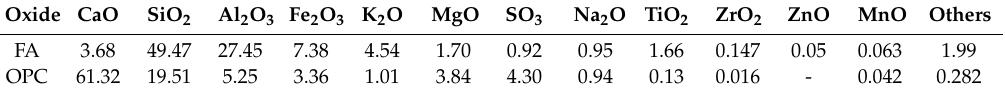
Figure 1. XRD analysis of used fly ash. Q—quartz (78-1256); M—mullite (73-1253). Table 1. Chemical composition of fly ash and ordinary Portland